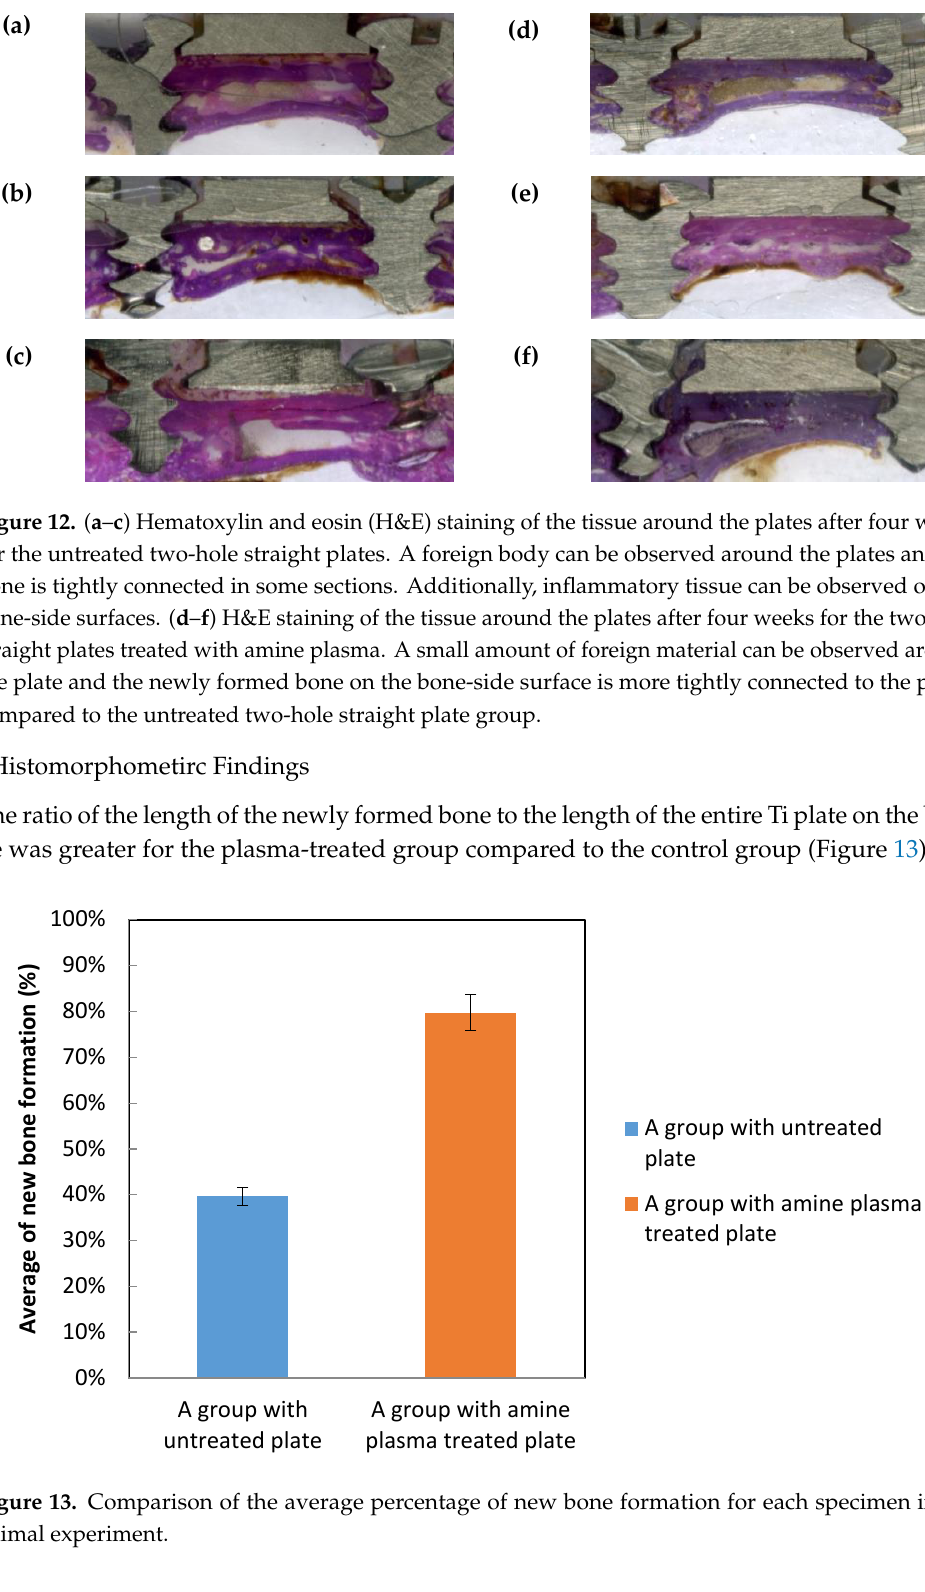
( b ) Figure 11. Four weeks after the initial operation, the untreated two-hole straight plate ( a ) and two-hole straight plate treated with amine plasma ( b ) were dissected. The periosteum and surrounding tissue remained around the untreated two-hole straight plate. In contrast, a relatively clear separation of tissue around the two-hole straight plate treated with plasma can be observed.